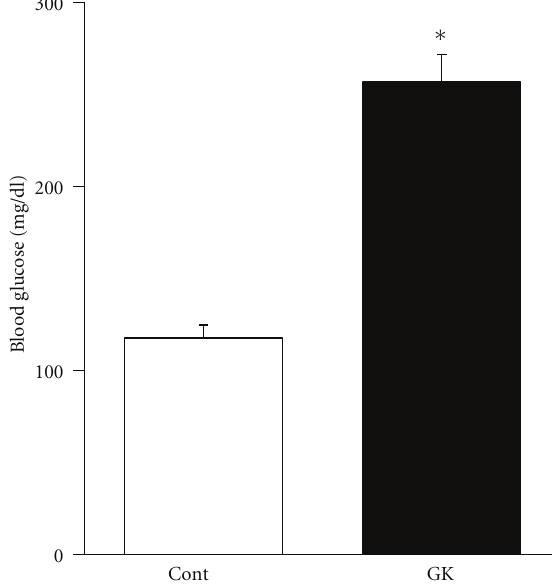
Figure 1: The mean blood glucose level in the Cont was 117 . 6 ± 7 . 1mg/dL and that in the GK was 256 . 7 ± 15 . 0 mg/dL. The blood glucose level was significantly higher in the GK rats than in the Cont rats. ∗ P < 0 .